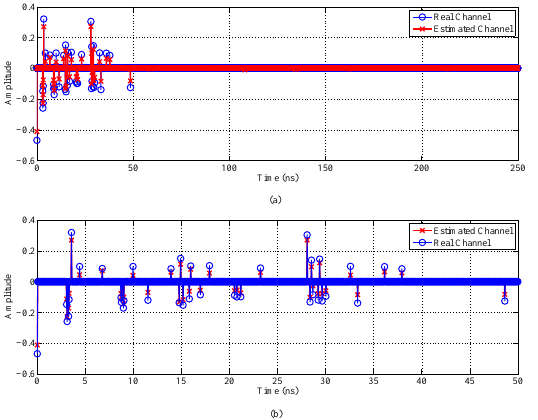
Figure 32. (a) Channel estimation result. (b) Zoomed in version of the